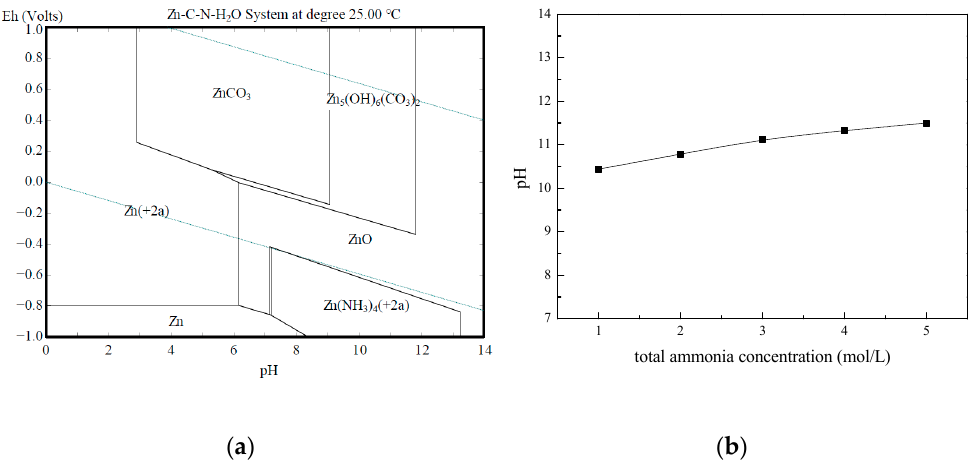
Figure 3. ( a ) Pourbaix diagram of the Zn–C–N–H 2 O system (25 ° C, 0.08 mol/L Zn, 1 mol/L NH 4 HCO 3 , 3 mol/L NH 3 ·H 2 O); ( b ) pH values of the NH 3 –NH 4 HCO 3 –H 2 O system (the ammonia/ammonium ratio was 3:1).